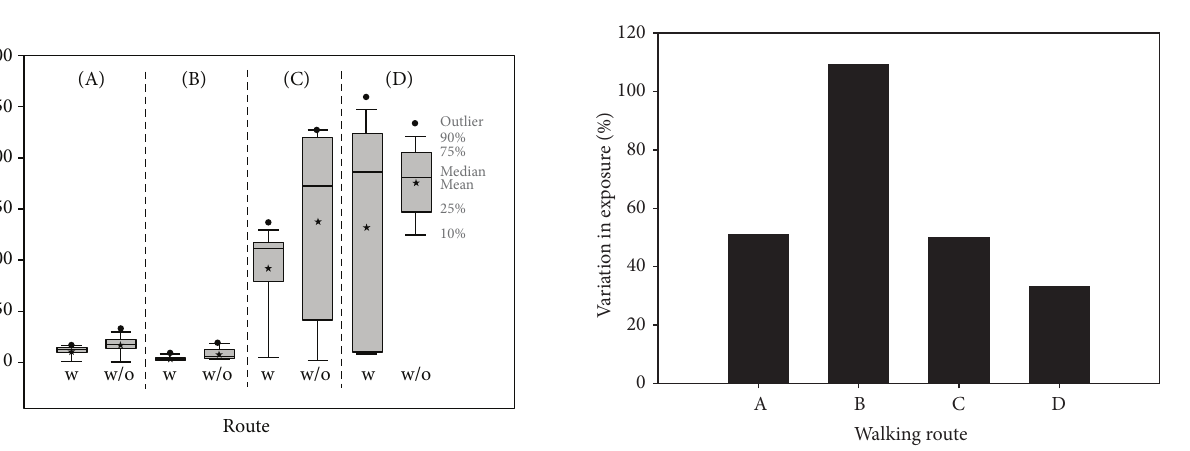
Figure 6: Box plot of the simulated exposure values for each route, comparing the results obtained with (w) and without (w/o) the influence of trees.